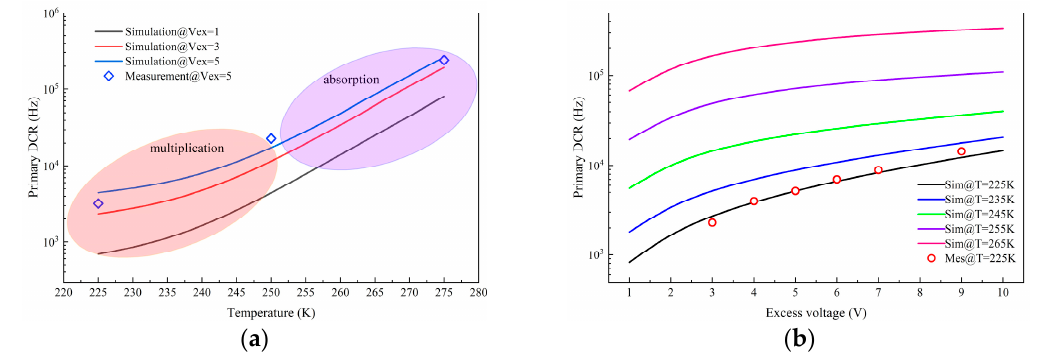
Figure 8. ( a ) Simulation results of the primary DCR with temperatures at three different excess voltages. ( b ) Simulation results of the primary DCR with excess voltages at five different temperatures.